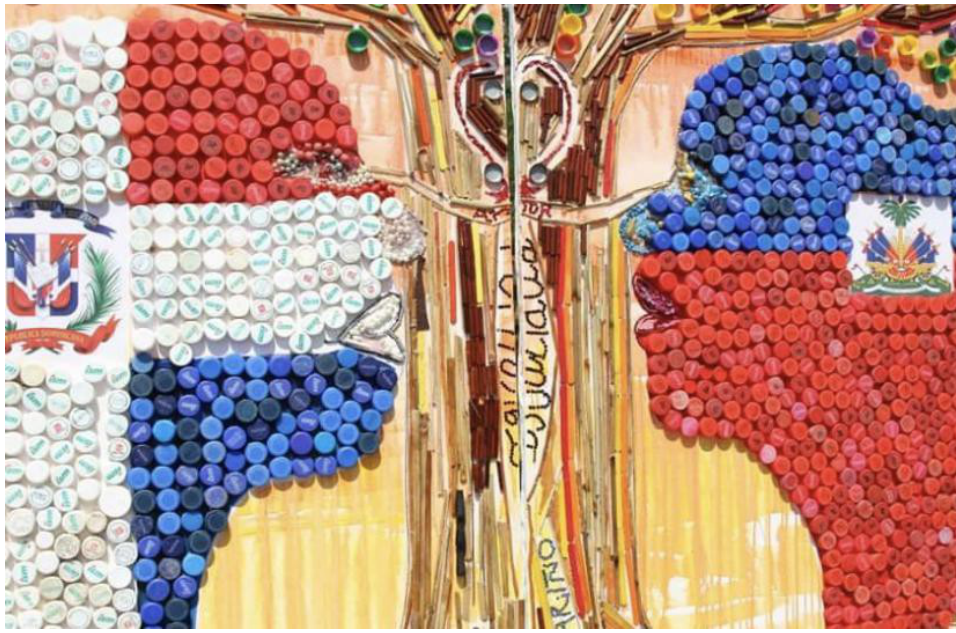
FFigigururee 33 Mural de Amistad, photography by E. Suero,